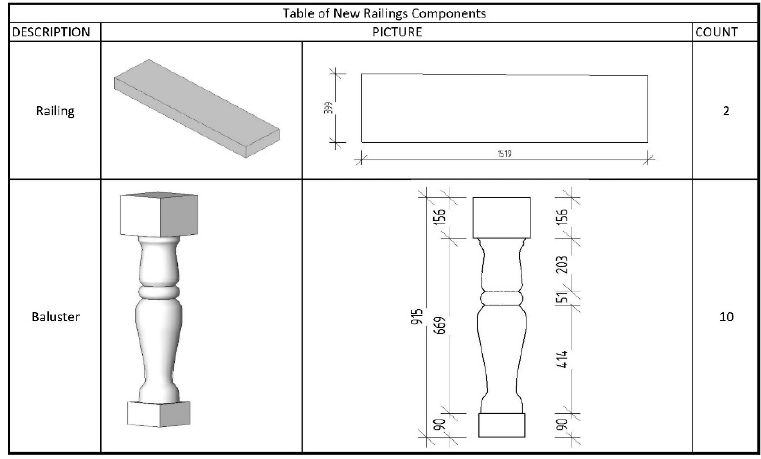
Figure 15. New parts of the